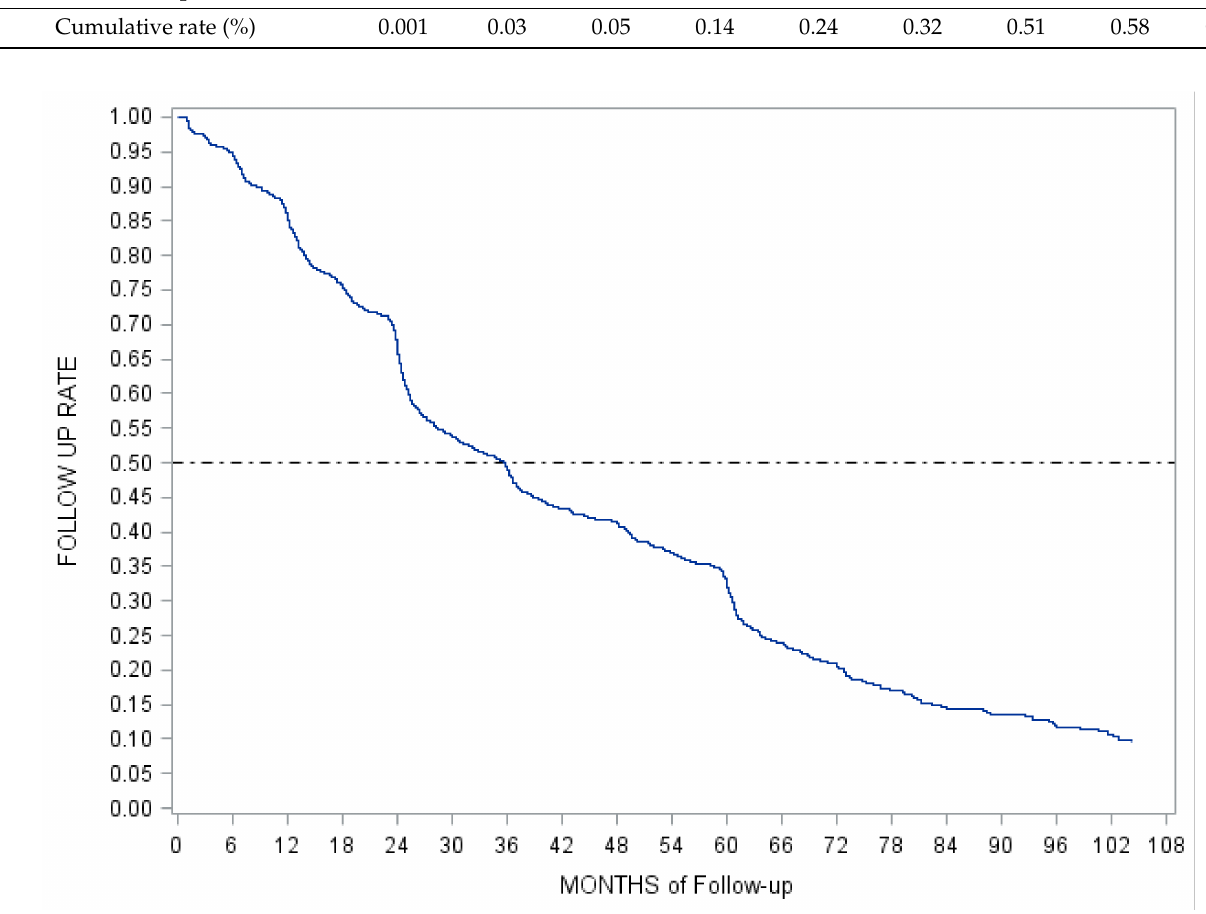
Figure A1. Follow-up rate according to post-operative months of